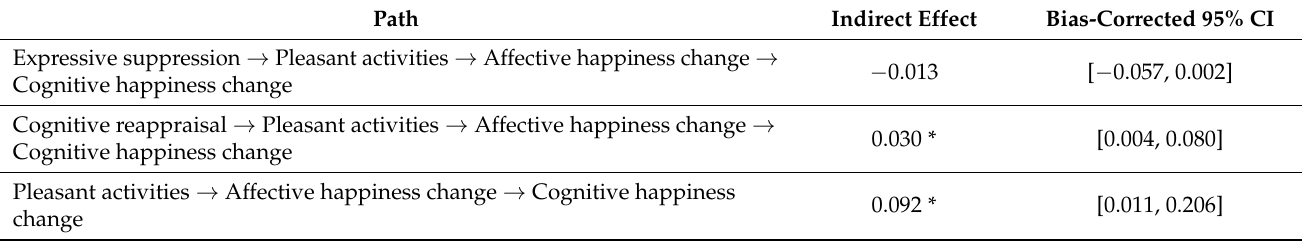
Table 3. Standardized indirect effects and confidence intervals for the path